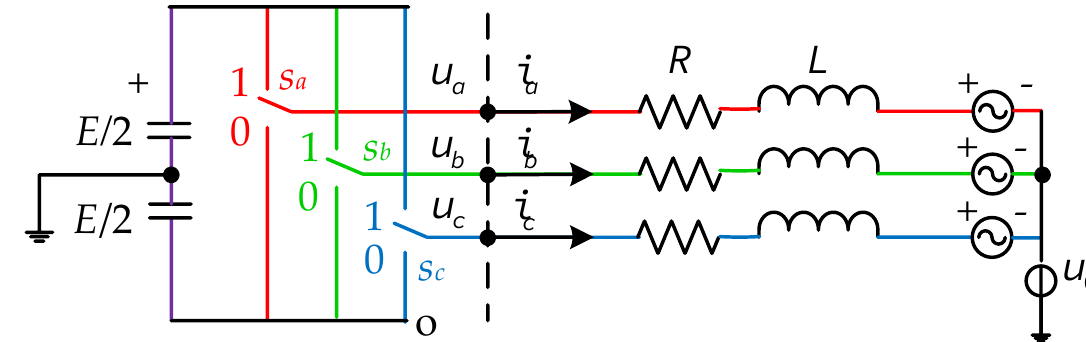
Figure 1. Equivalent circuit of a three-phase active power filter (APF).